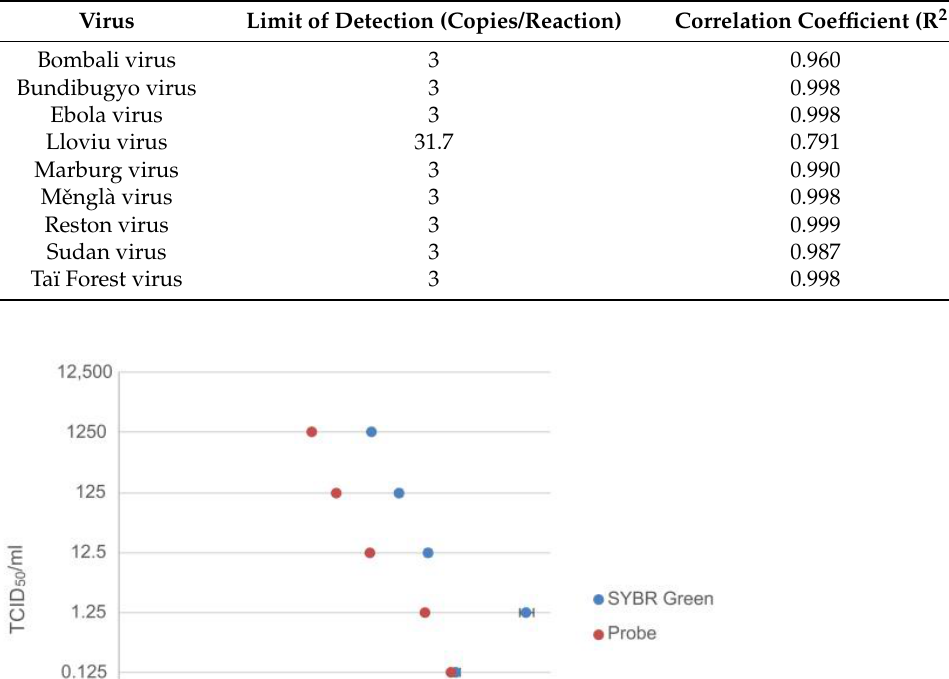
Figure 4. Standard curves for the serially diluted (10 5 –10 9 copies/reaction) standard templates. Table 5. The SYBR Green assay characteristics for serially diluted standard templates.